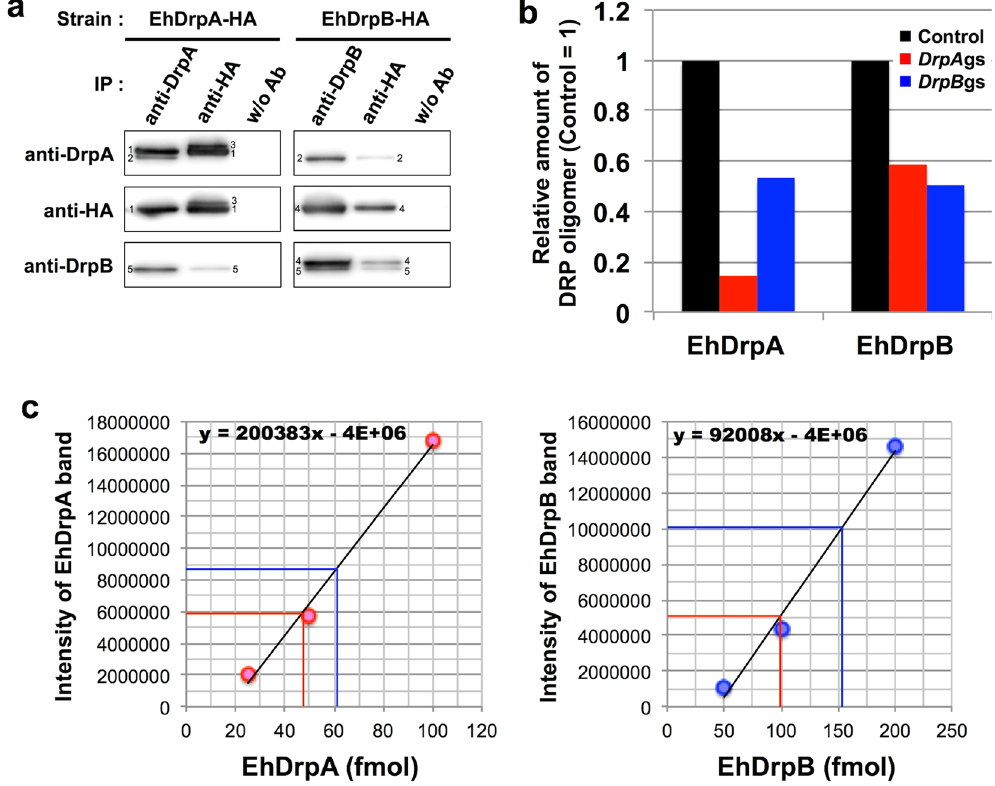
Figure 5. Analyses of EhDrpA-EhDrpB interaction. ( a ) Immunoprecipitation and immunoblot analysis of EhDRPs. EhDrpA and EhDrpB were immunoprecipitated from whole cell lysates (1 mg protein) of EhDrpA-HA and EhDrpB-HA strains using anti-DrpA, anti-DrpB, and anti-HA antibodies. Immunoprecipitation was also carried out without antibody (“w/o Ab”). Immunoprecipitated proteins were subjected to SDS-PAGE (about 150 µ g protein per lane). Antibodies used for immunoprecipitation (IP) and immunoblots are indicated. Individual bands are labeled as follows: 1, EhDrpA-HA; 2, endogenous EhDrpA; 3, post-translationally modified EhDrpA-HA; 4, EhDrpB-HA; 5, endogenous EhDrpB. Original and unclipped immunoblots are shown in Supplementary Fig. S10. ( b ) Relative amounts of EhDrpA and EhDrpB in the 900-kDa EhDRP complex of DrpA gs, DrpB gs, and control strains. DrpA gs (red bars), DrpB gs (blue bars), and control (black bars) denote the strains in which EhDrpA or EhDrpB gene was silenced, and control strain, respectively. The intensities of the bands in the immunoblots (Supplementary Fig. S11) were measured and shown relative to the control. ( c ) A standard curve for the quantification of EhDrpA and EhDrpB in the hetero-oligomer. EhDRP was immunoprecipitated from trophozoites of E . histolytica HM-1:IMSS cl6 wild type by anti-DrpA or anti-DrpB antibodies. Shown on the horizontal axis are the amounts of each EhDRP (in fmol). On the vertical axis, the intensity of EhDrpA and EhDrpB bands in the immunoblots are shown respectively (see also Supplementary Fig. S12). Circles indicate the recombinant histidine-tagged (His 6 )-EhDRP-HA proteins of various known amounts used as standards, and measured for band intensities in immunoblots using specific antibodies against EhDRPs. Standard curves were created by linear regression. Red and blue lines indicate the intensities of the detected EhDrpA and EhDrpB bands in immunoblots of the immunoprecipitated samples by anti-DrpA and anti-DrpB antibodies, and the estimated amount of EhDrpA and EhDrpB,